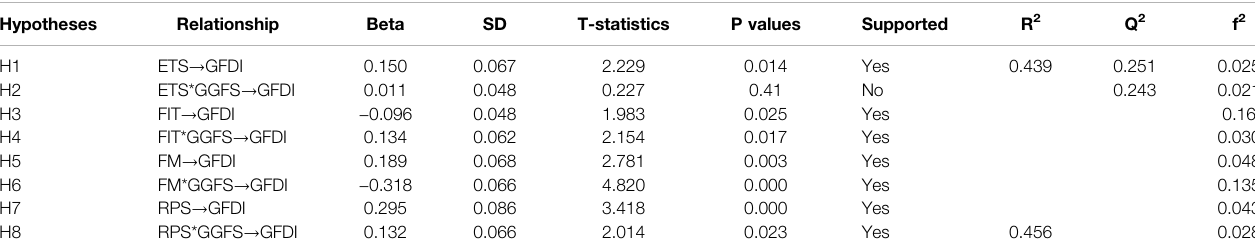
TABLE 5 | Structural assessment model results (hypothesis